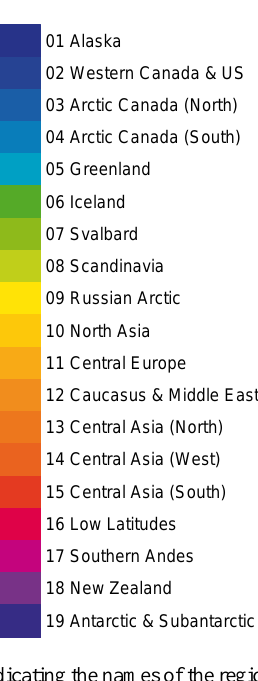
Fig. 2. Color bar indicating the names of the regions shown in Fig. 1, and the colors in the following